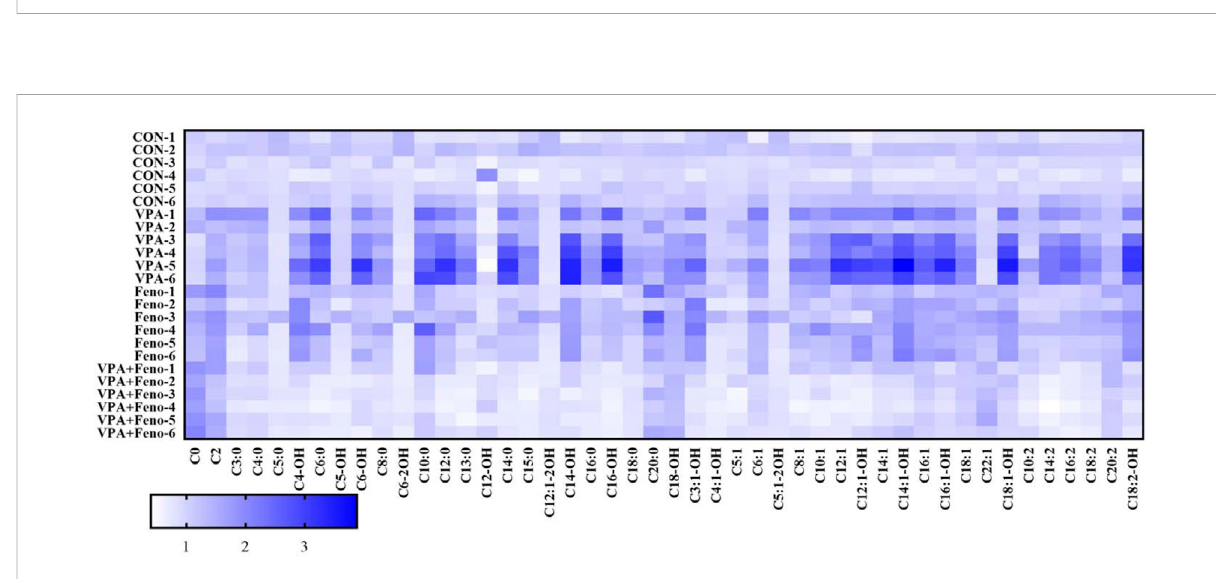
FIGURE 12 Heat map analysis of the effect of Feno on plasma ACs pro fi le in VPA-induced hepatotoxic mice. CON: control group; VPA: VPA 500 mg/kg group; Feno: Feno50 mg/kg group; VPA + Feno: VPA 500 mg/kg + Feno50 mg/kg